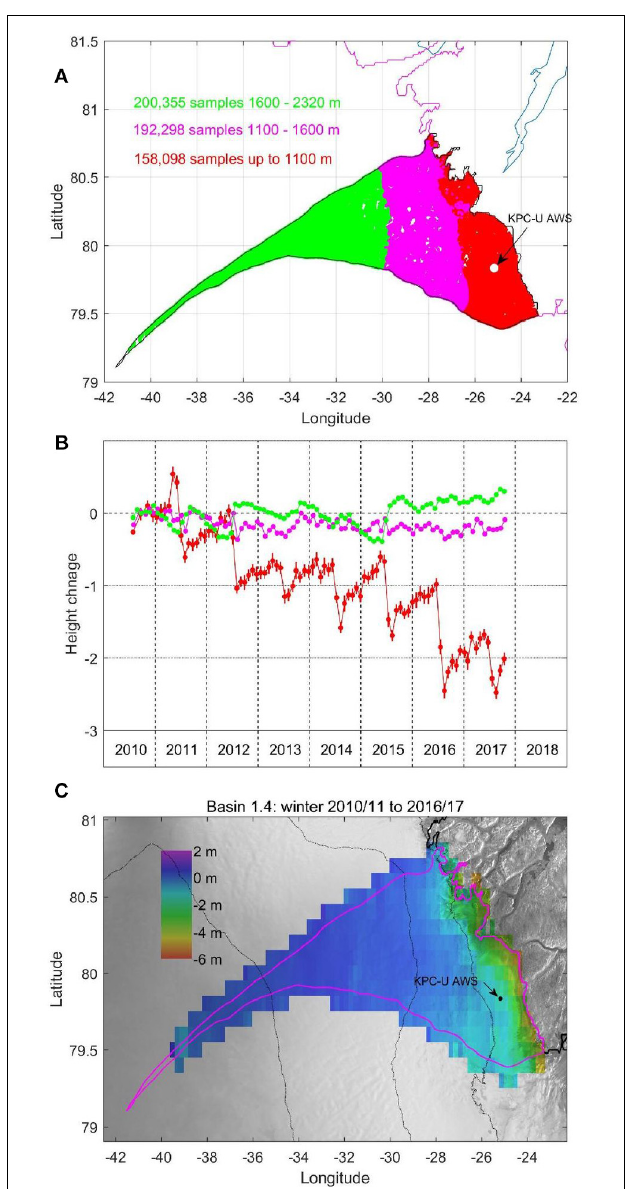
FIGURE 10 | (A) The red, magenta and green colored dots indicate the positions of the Cryosat data in basin 1.4. The elevation ranges are: red; ice sheet edge to 1100 m, magenta; 1100–1600 m, and green; 1600–2320 m. (B) Temporal height change for the three elevation ranges in A . (C) Six-year height loss derived from Cryosat data. Position of the KPCU AWS is shown with the black dot.